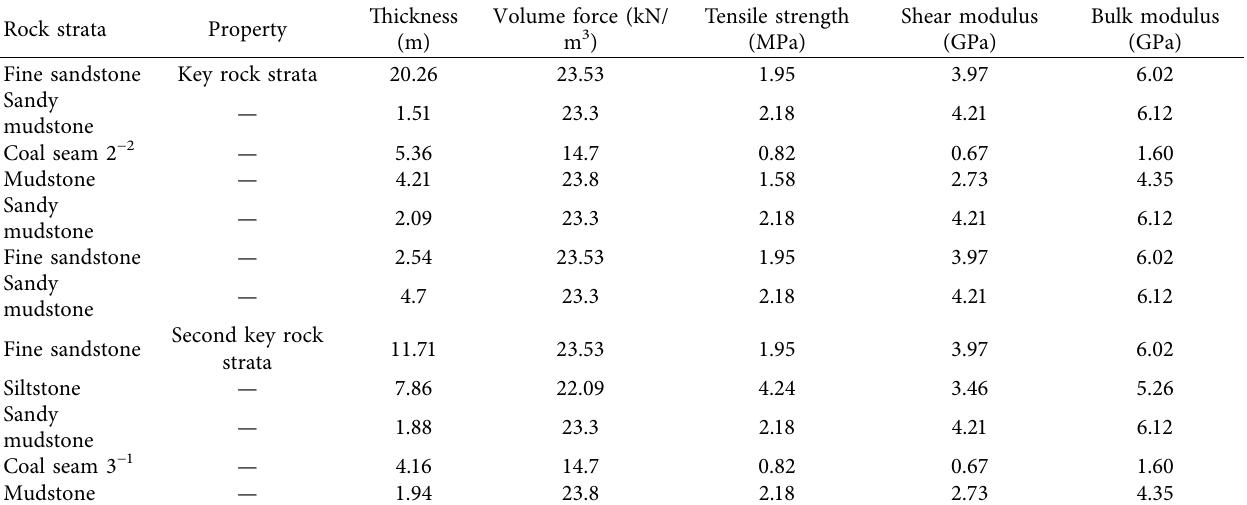
Table 1: Mechanical parameters of the coal seam 2 − 2 -3 − 1 in the Huoluowan Coal